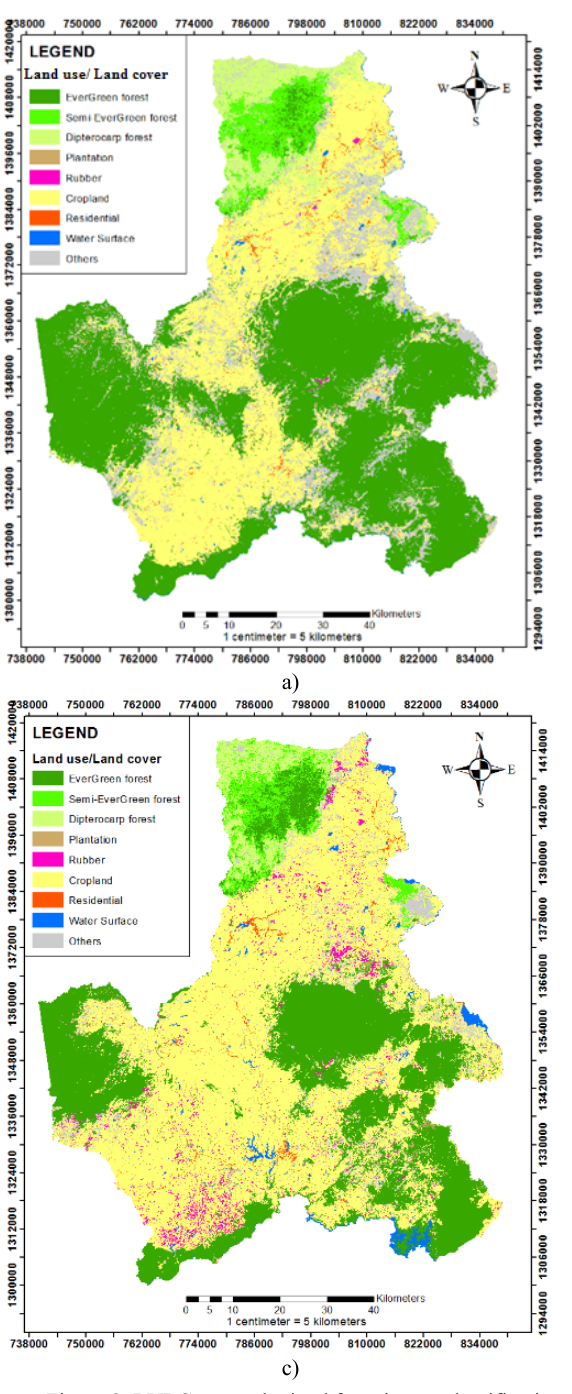
Figure 2. LULC maps obtained from image classification of the four time-periods: a) 2005, b) 2010, c) 2015 and d) 2018 Based on the classified images over the years (2005-2010-2015- 2018), the changes of the LULC area are summarized in Figure 3. In general, for forest classes, the area of natural evergreen forest and dipterocarp forest decreased over the years. In contrast, the area of semi-evergreen and planted forests gradually increased over periods. For non-forest cover categories, the area of crop-land cover, residential cover, and water surface cover increased over the years due to economic, hydropower, social development, and population growth, while other types of land were volatile but the trend declined over